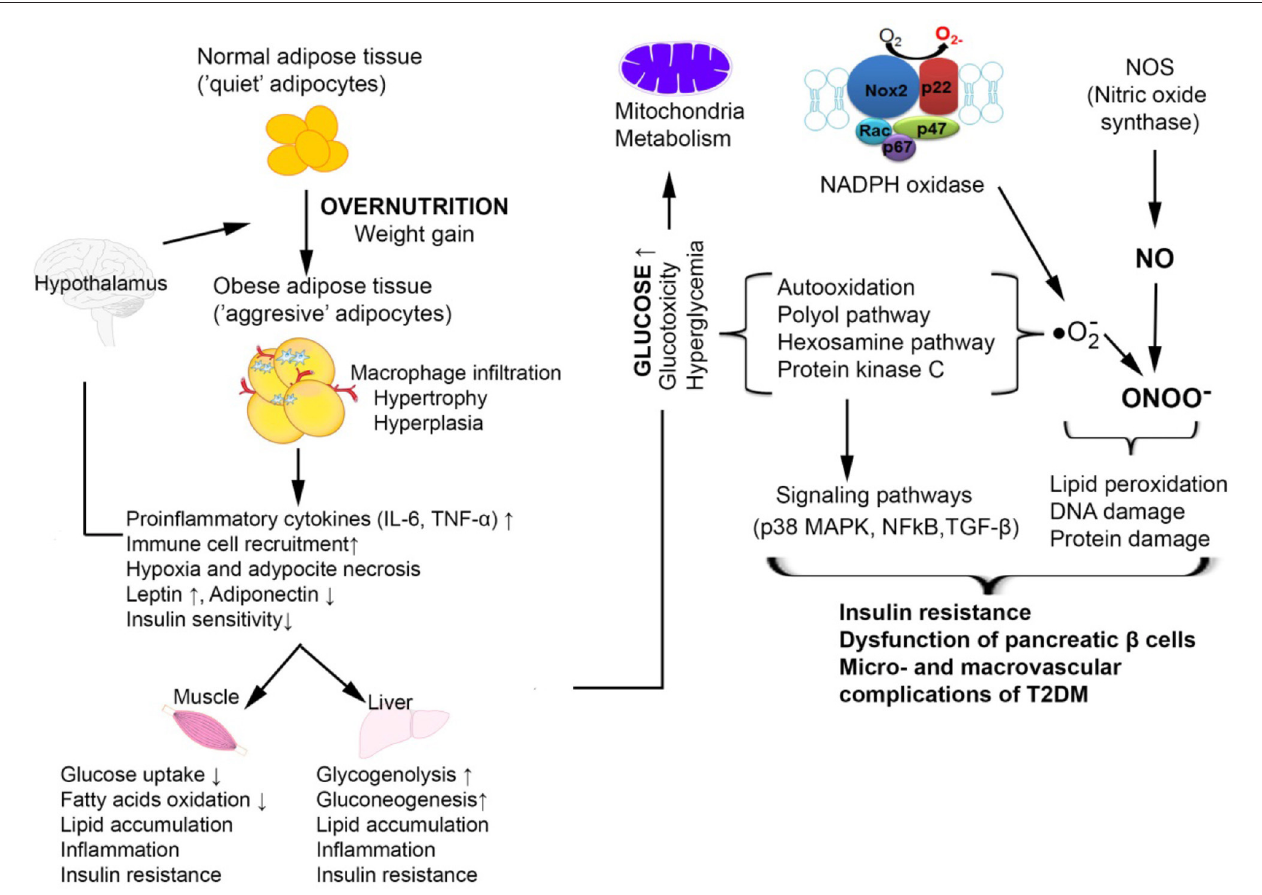
FIGURE 3 | Cellular mechanisms by which oxidative stress is involved in T2DM associated with obesity [adapted after (57)]. In obesity, the expansion of the adipose tissue promotes increased macrophage infiltration and inflammation with increased production of pro-inflammatory cytokines TNF α and IL-6. This is accompanied by an increased release of free fatty acids and an aberrant secretion of adiponectin and leptin. The resulting chronic hyperglycemia determines the activation of glucose self-oxidation processes that lead to the formation of highly reactive hydroxyl radicals which together with nitric oxide (NO) forms peroxinitrite, a very aggressive radical that causes oxidative damage to DNA, proteins, and lipids. The increased oxidative stress also activates signaling pathways such as p38 MAPK, NF- κ B which are involved in insulin resistance and vascular complications of